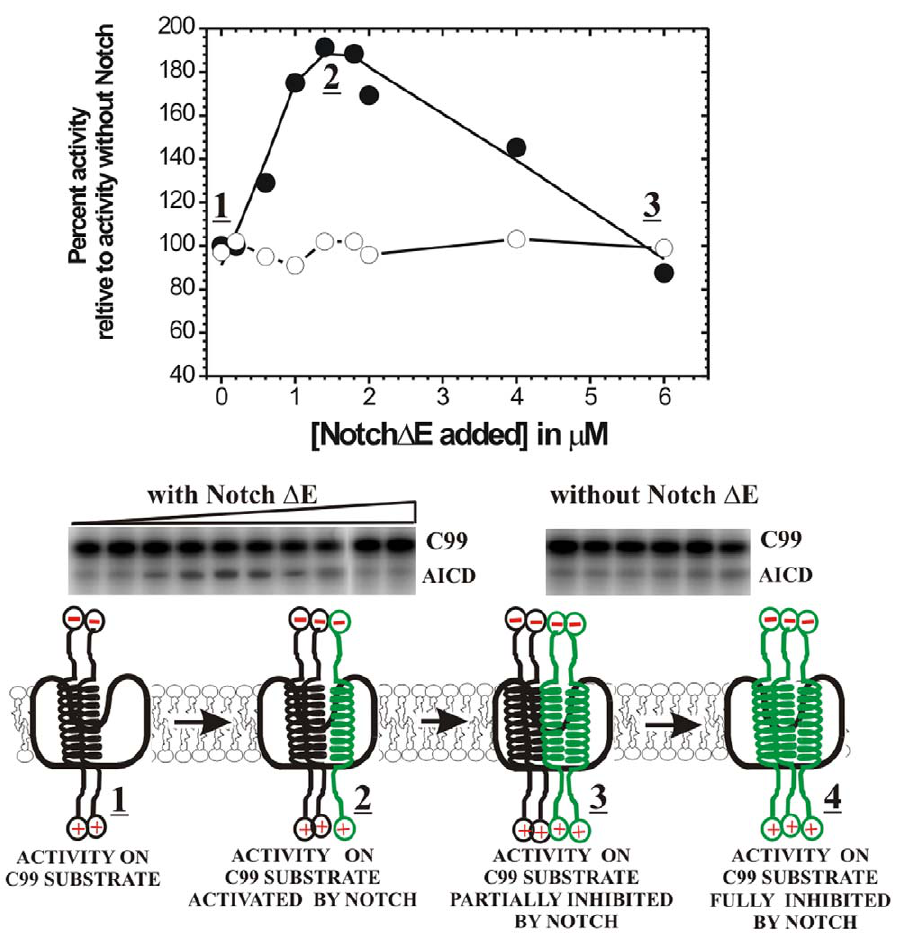
Figure 6. Notch D E substrate can activate c -secretase activity on C99 substrate. c -Secretase activity in CHAPSO enriched membranes was N measured using half-saturating C99 substrate ([C99]=0.45 m M, fresh after purification) in the presence of increasing concentration of Notch D E ), and in identical control assays without Notch D E substrate (O). The AICD production was measured using 125-I labeled C99 substrate substrate ( and autoradiography as shown on the gel strips (125-I assay was used instead of western blot since both substrates were purified using antiflag M2 epitopes, see methods). Different interactions between c -secretase and its C99 (black helix) or Notch D E (green helix) substrates can be illustrated using a model mechanism. C99 substrate can be shown as a transmembrane helix [42], while c -secretase can be shown as a bowl-shaped membrane- imbedded complex [19]. The underlined numbers connect the different complexes with the corresponding activity range on the graph. In a simple scenario, of one enzyme binding one substrate, Notch D E and C99 substrates could be only competitive inhibitors [62]. We find that Notch D E substrate can activate c -secretase reaction on C99 substrate ( 1 ). Such scenario can happen only if c -secretase can bind both substrates at the same time ( 2 ). Notch D E substrate shows competition with C99 substrate only when its concentration is several folds higher than C99 concentration ( 3 ). Extrapolation of the presented profile shows that close to 10 m M of Notch D E substrate would be needed for a full inhibition ( 4 ).